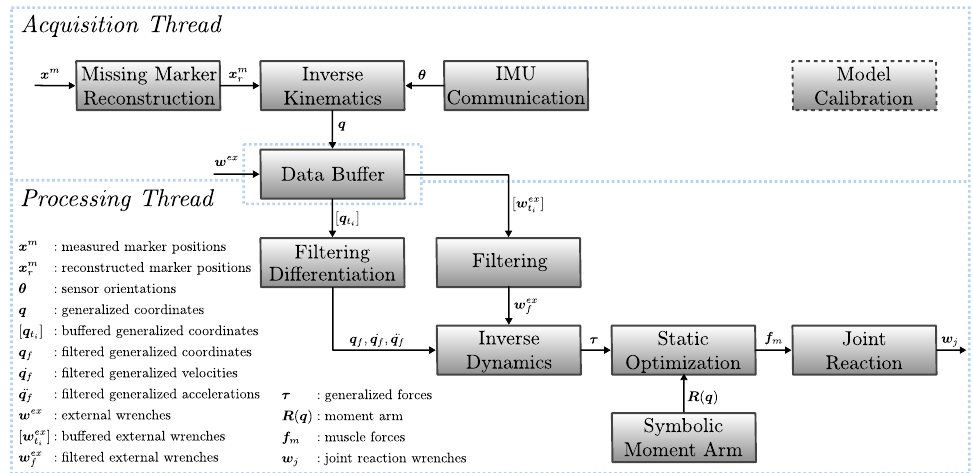
Figure 1. Overview of the real-time analysis pipeline. The acquisition thread collects raw data from sensor inputs and performs IK to obtain the kinematics from marker- and IMU-based sources. Data are shared using thread-safe data structures. Depending on the application, the processing thread can arrange the operations required to extract meaningful information from the musculoskeletal model in real-time. Model calibration refers to the process of adjusting the musculoskeletal model to account for the subject’s anthropometric parameters using static trials and functional